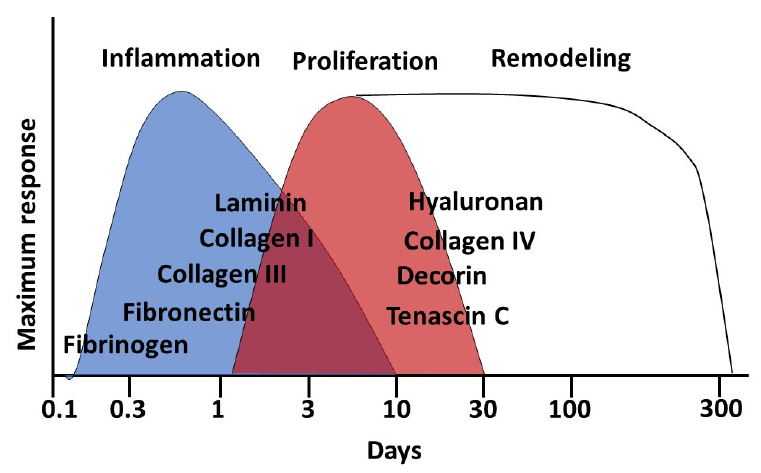
Figure 1. Wound healing stages and main involved components of the extracellular matrix of the skin.